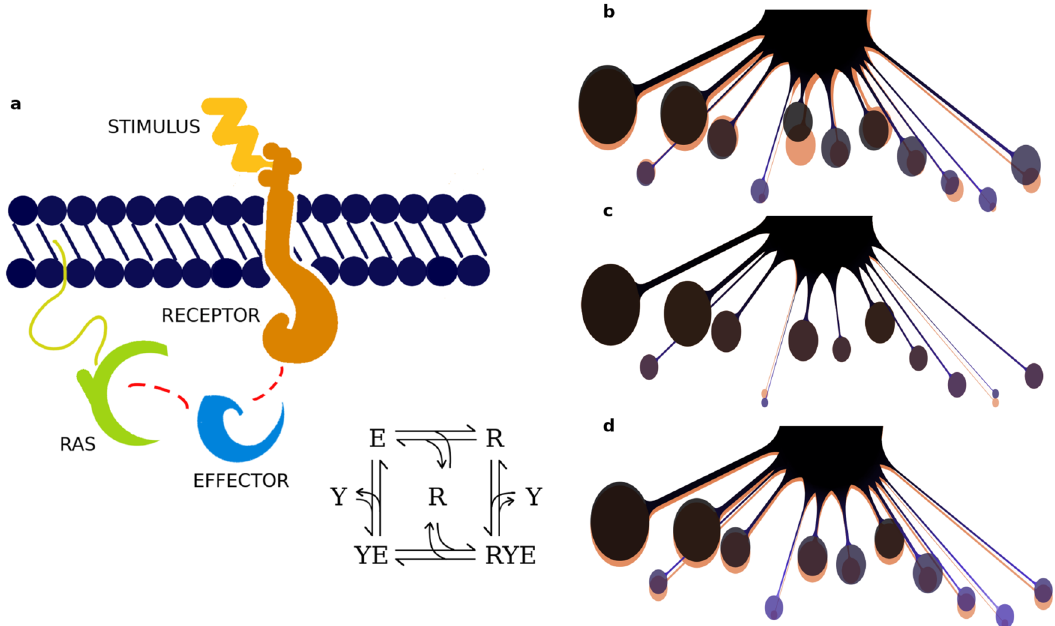
Fig. 7 Stimulus-dependent mechanism of network rewiring. a Graphical representation and reaction scheme of receptor-mediated Ras- effector interactions. Such compounds can assemble via the Ras binding domain (RBD), either directly, or through the piggyback mechanism (receptor-mediated). This latter is triggered by external stimulation (e.g. EGF) and induces the recruitment of an effector to bind a (active) transmembrane receptor (via a speci fi c domain, e.g. SH2 or PDZ). As a result, the concentration of effector proteins at the membrane, that can then assemble into a complex with Ras, is enhanced. b – d “ Octopus ” plots visualizing the amount of Ras-effector complexes (%) associated to 12 downstream pathways. In orange, it is represented the reference (unstimulated) Ras-binding pro fi le (20% active Ras was assumed), which is overlapped to the pro fi le, in purple, perturbed with b EGF, c PVRL3, or d the combination of the two stimuli (in those three cases, as a consequence of stimulation, 90% active Ras was considered). Stimulus-induced rewiring is the result of a change in competitivity among the effectors, and re fl ects the property, for the Ras network, to be able to adapt and respond to the speci fi c cell